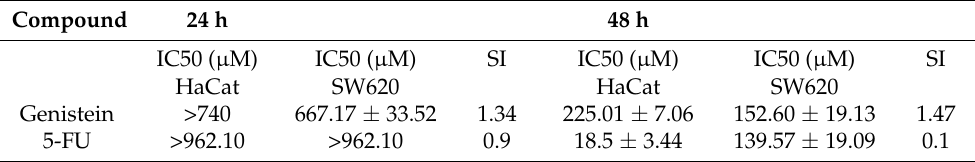
Table 2. Cytotoxic effect of genistein in HaCaT and SW620 cells.